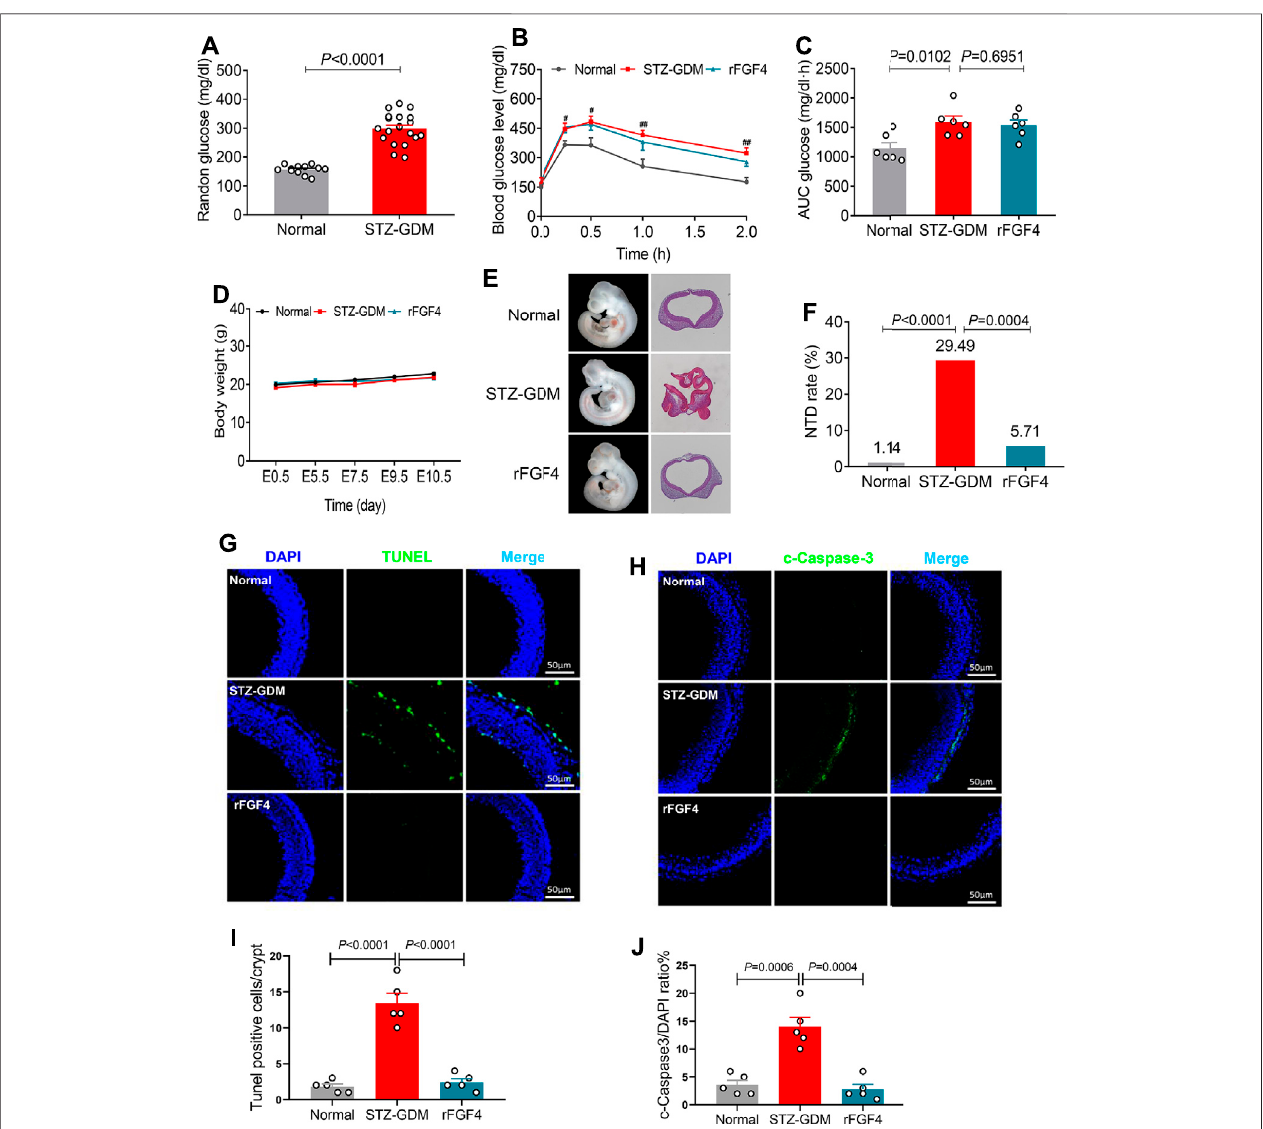
FIGURE5| rFGF4treatmenthasnoeffectofglucoseloweringinSTZinducedmice,butitalleviatesSTZinducedNTDformationandresorption. (A) Randomblood glucoselevelsinnormalandSTZinducedGDMgroups( n =11). (B – C) Aglucosetolerancetest(GTT)done (B) andtheaccompanyingintegratedareaundercurve(AUC) forchangesinbloodglucose (C) atE9.5( n =6). # p < 0.05, ## p < 0.01STZ-GDMversusnormalmice. (D) Bodyweightchangesofeachgroupmice. (E) Closedandopen neural tube structures of E10.5 embryos from control, STZ induced GDM and rFGF4-treated mice. (F) NTD formation rates of embryos from control, STZ induced GDMand rFGF4-treated groups. (G) TUNEL assayshowingapoptotic cells (green signal). Cell nucleiwerestainedwith DAPI(blue). Scale bar =50 μ m. (I) Quanti fi cation ofTUNELpositivecellsin (G) ( n =5). (H,J) Immuno fl uorescencestainingandquanti fi cationofcleaved-Caspase3inE10.5embryosfromcontrol,STZinducedGDMand rFGF4-treated mice. Scale bar = 50 μ m (n =